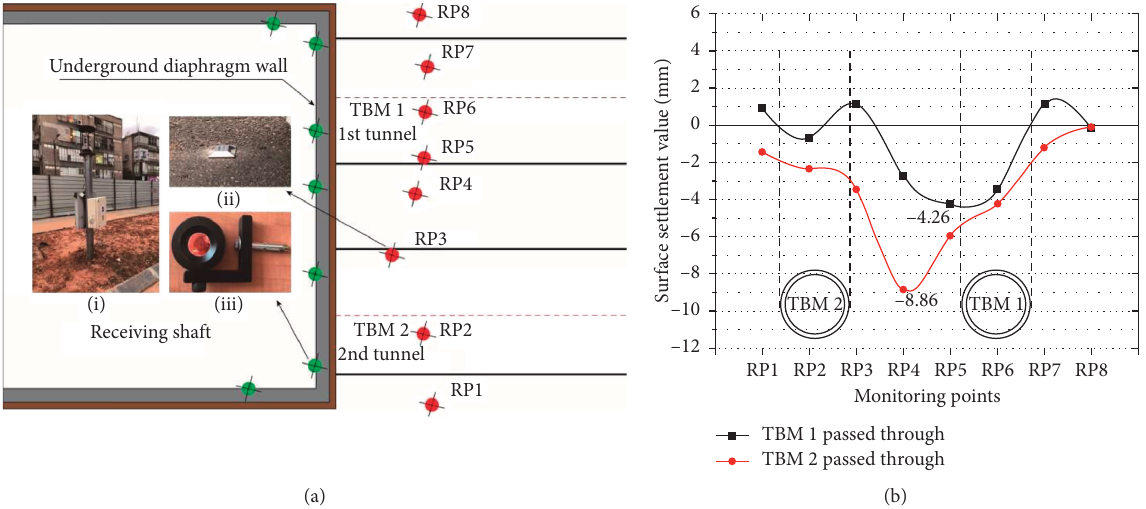
Figure 17: Monitoring and analysis of surface subsidence: (a) distribution of monitoring points (i) total station, (ii) prism on the ground surface, and (iii) prism on the diaphragm wall); (b) surface subsidence curve.